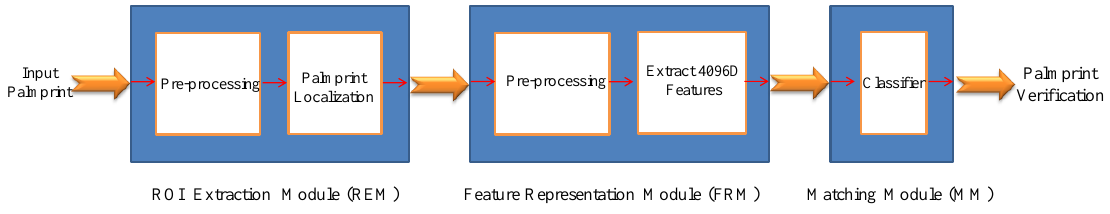
Figure 2. Our proposed model for palmprint verification. ROI: region of interest.